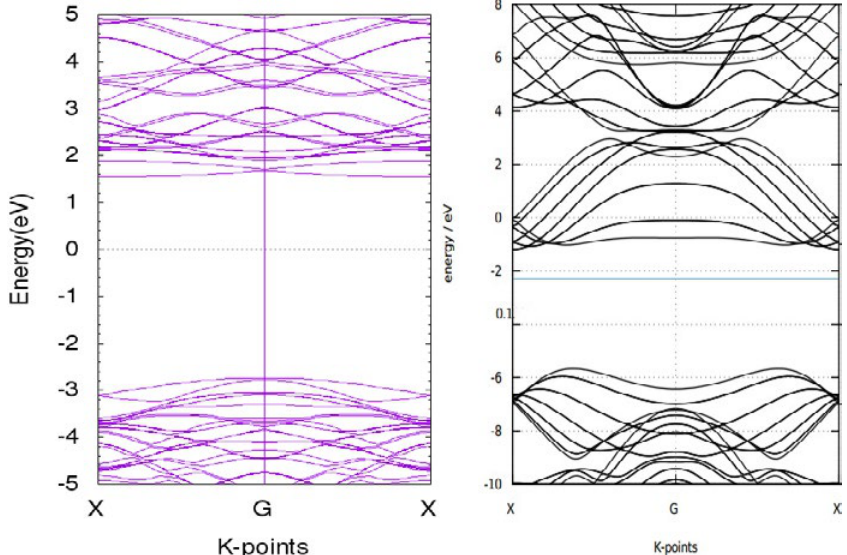
Figure 2. Electronic band structures for the unit cell and supercell of the considered BN nanotube.